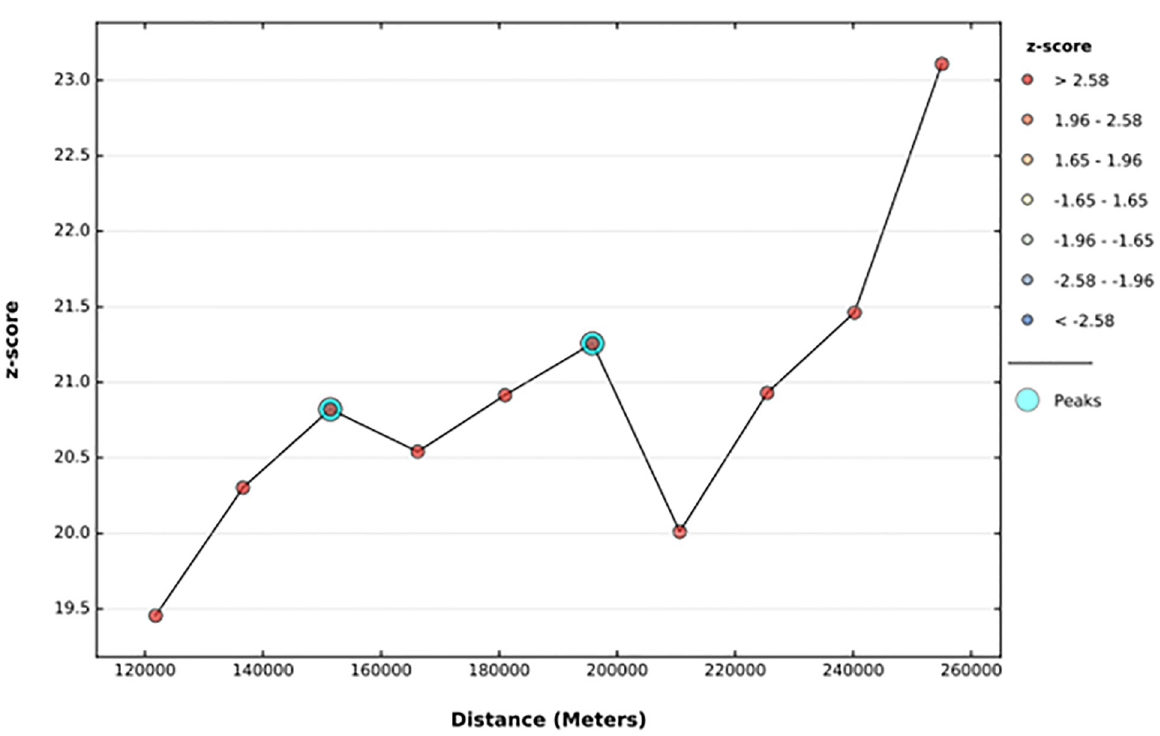
Fig 6. The incremental autocorrelation of anemia among reproductive age women in Ethiopia by a function of distance using Ethiopian demographic and health surveys 2016.